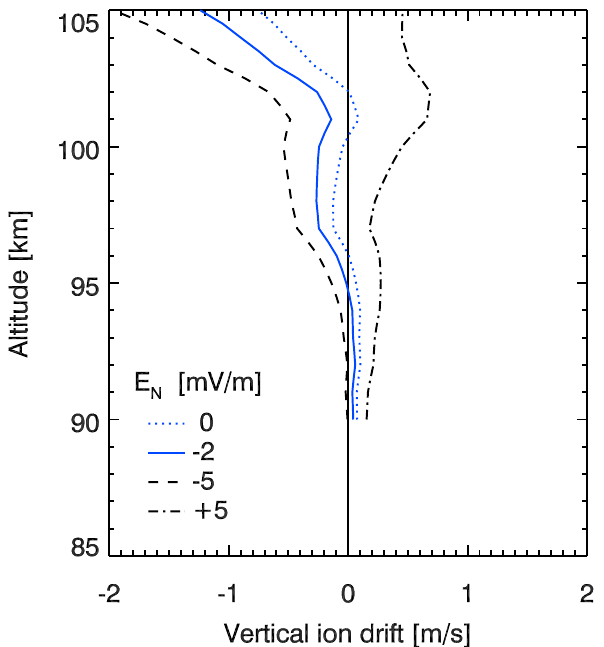
Figure 7. Vertical ion drift as calculated based upon the observed wind shear from flight 41.078 and different meridional electric